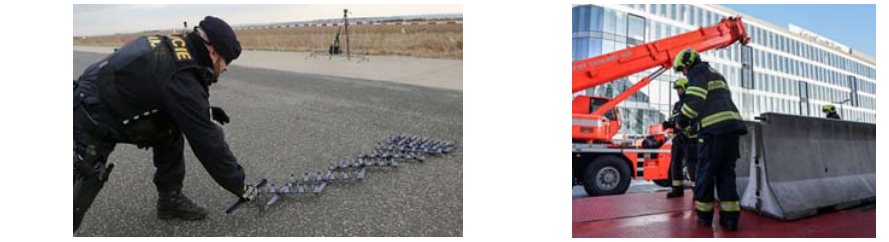
Figure 4 – Application of a portable road barrier spike system and the assembly of prefabricated